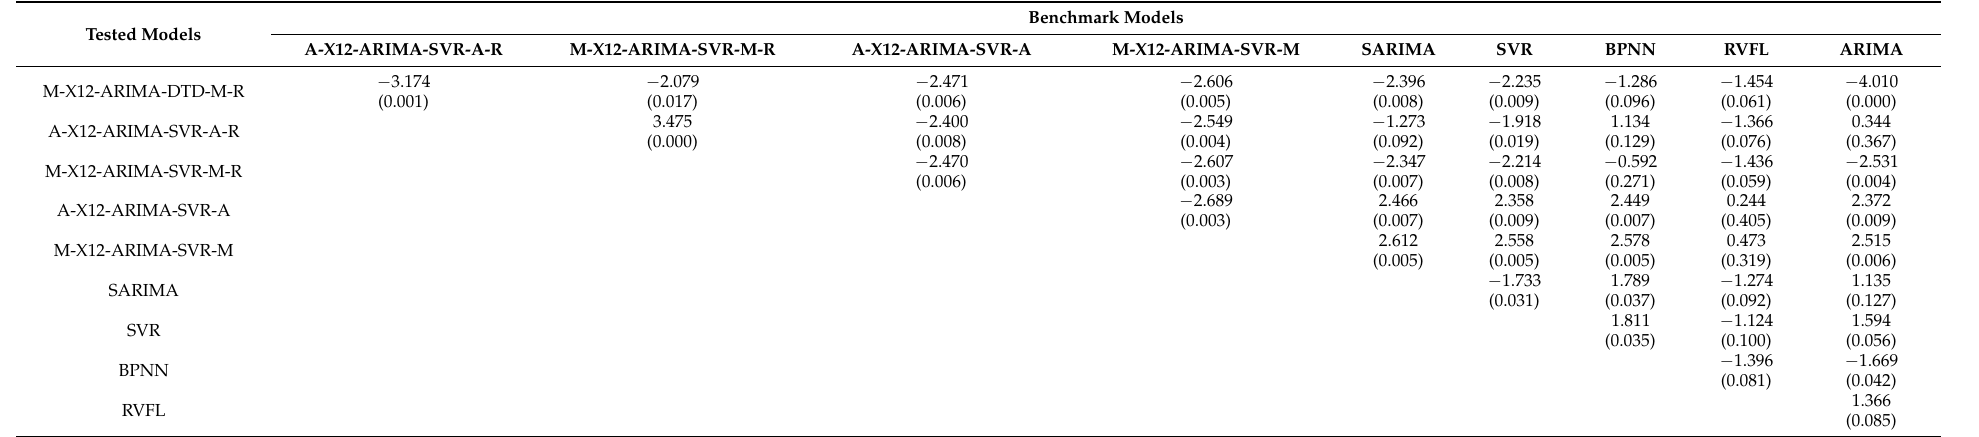
Table 17. DM test results across different models for gasoline consumption data in Henan.